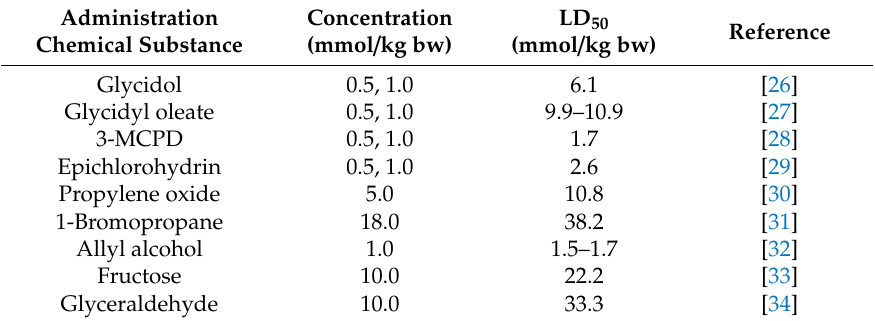
Table 1. Administered concentrations of glycidol and related